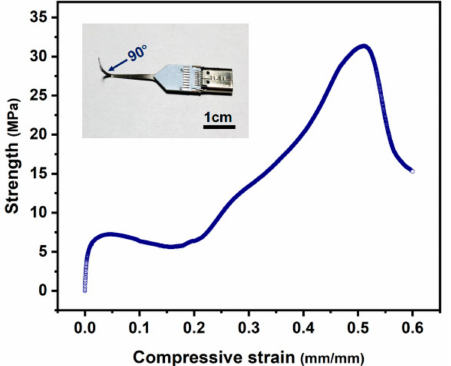
Figure 8. A typical stress–strain curve under compression for an as-fabricated 20 mm-long freestanding probe (shown in the inset).